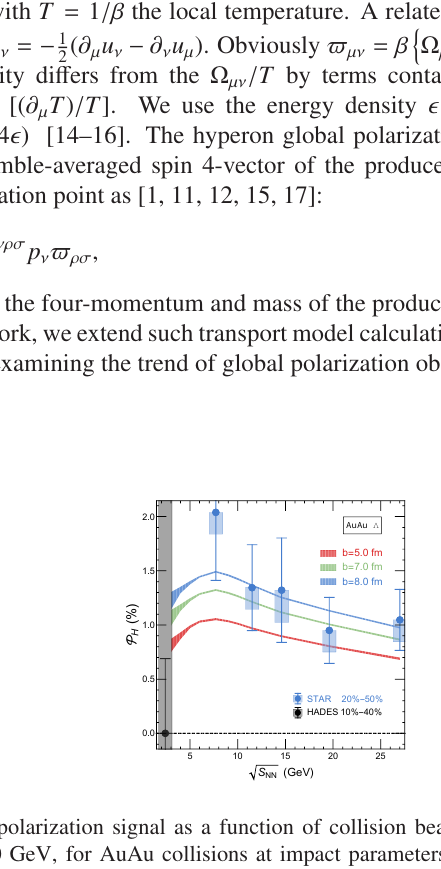
Figure 1. Λ global polarization signal as a function of collision beam energy with 0 . 4 GeV < p T < 3 . 0 GeV, for AuAu collisions at impact parameters b = 5 fm (red), 7 fm (green) and 8 fm (blue), with the bands representing statistical uncertainty from our simulation. Relevant measurements are also shown, with the STAR data from Ref.[1] and the HADES data from Ref.